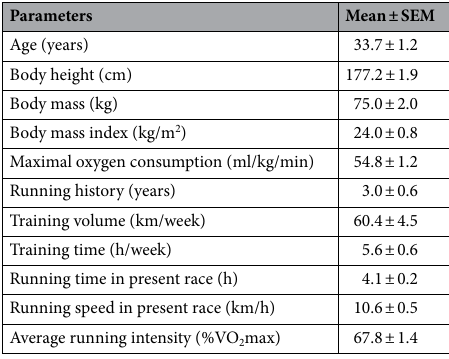
Table 1. Subject characteristics ( n =